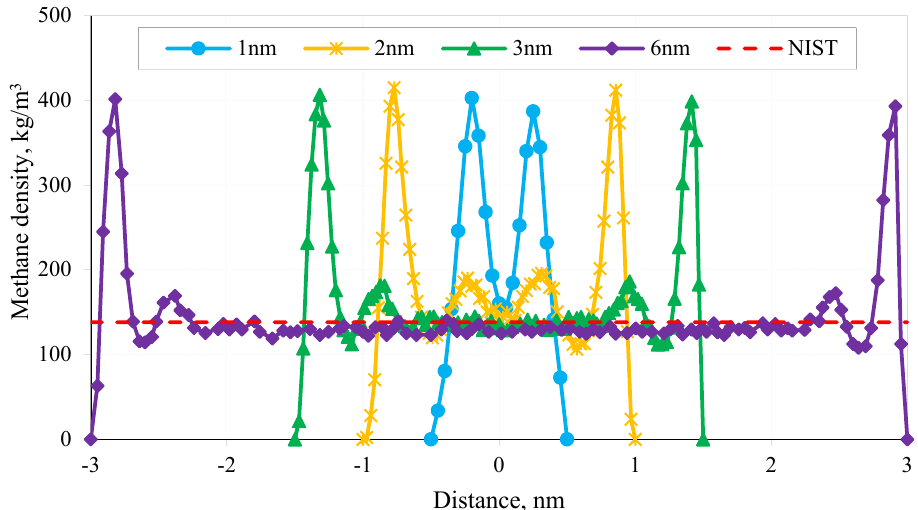
Figure 11. Density distribution curves of methane in pore spaces of different sizes.